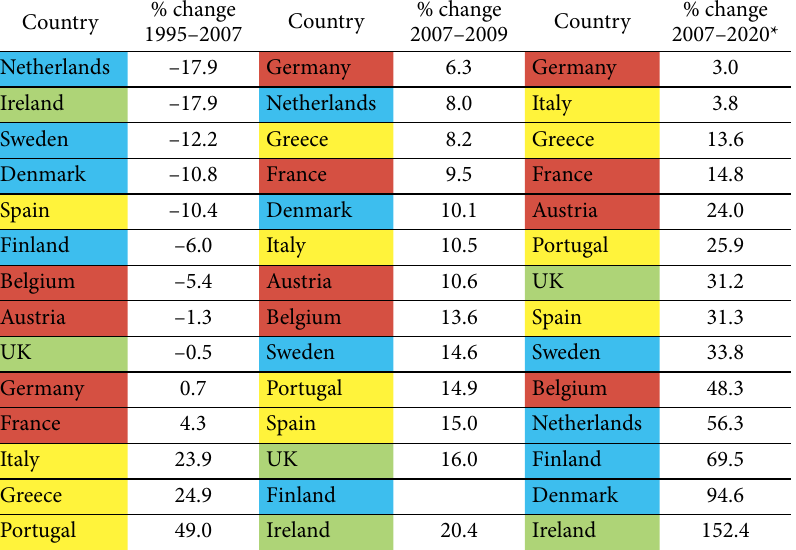
Table 4. The change of social public expenditure on pensions as % of GDP,